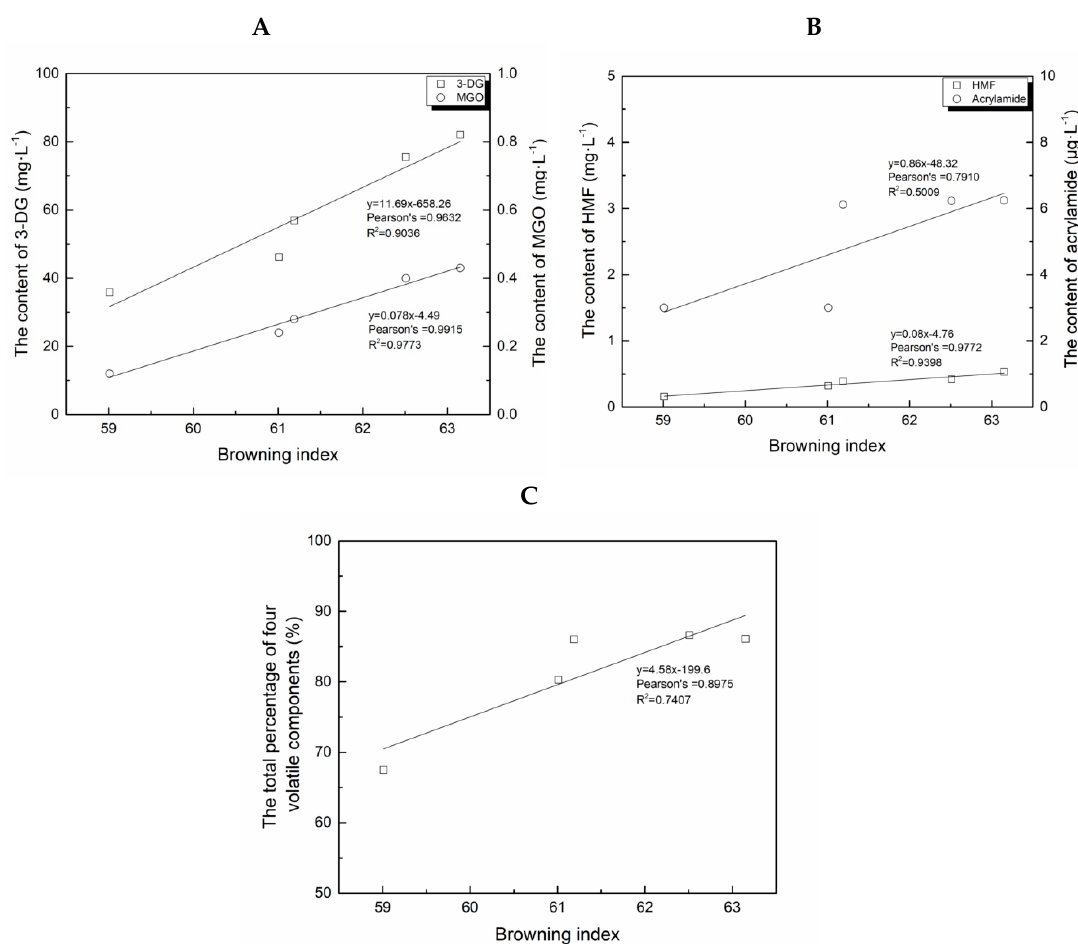
Figure 2. Correlations between the browning index (BI) and the levels of different compounds during the browning of brown fermented milk (BFM). ( A ) Correlations between deoxyglucosone (3-DG) and methylglyoxal (MGO) and BI changes. ( B ) Correlations between 5-(hydroxymethyl)-2-furfural (HMF) and acrylamide levels in BI changes. ( C ) Correlation between the changes in the total percentages of volatile compounds and BI alterations ( n =